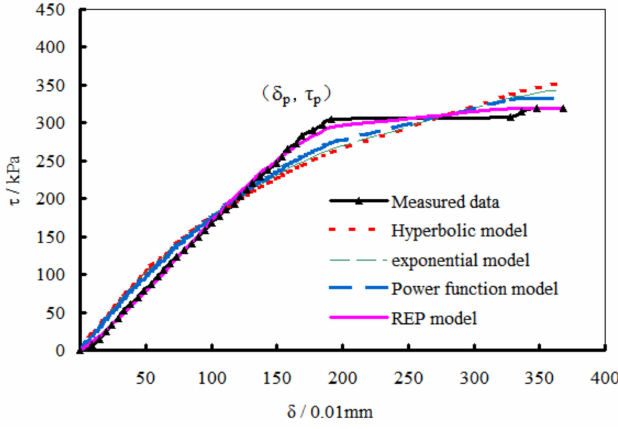
Figure 8. τ - δ curve for mix ratio with 20% (cid:24) Nm